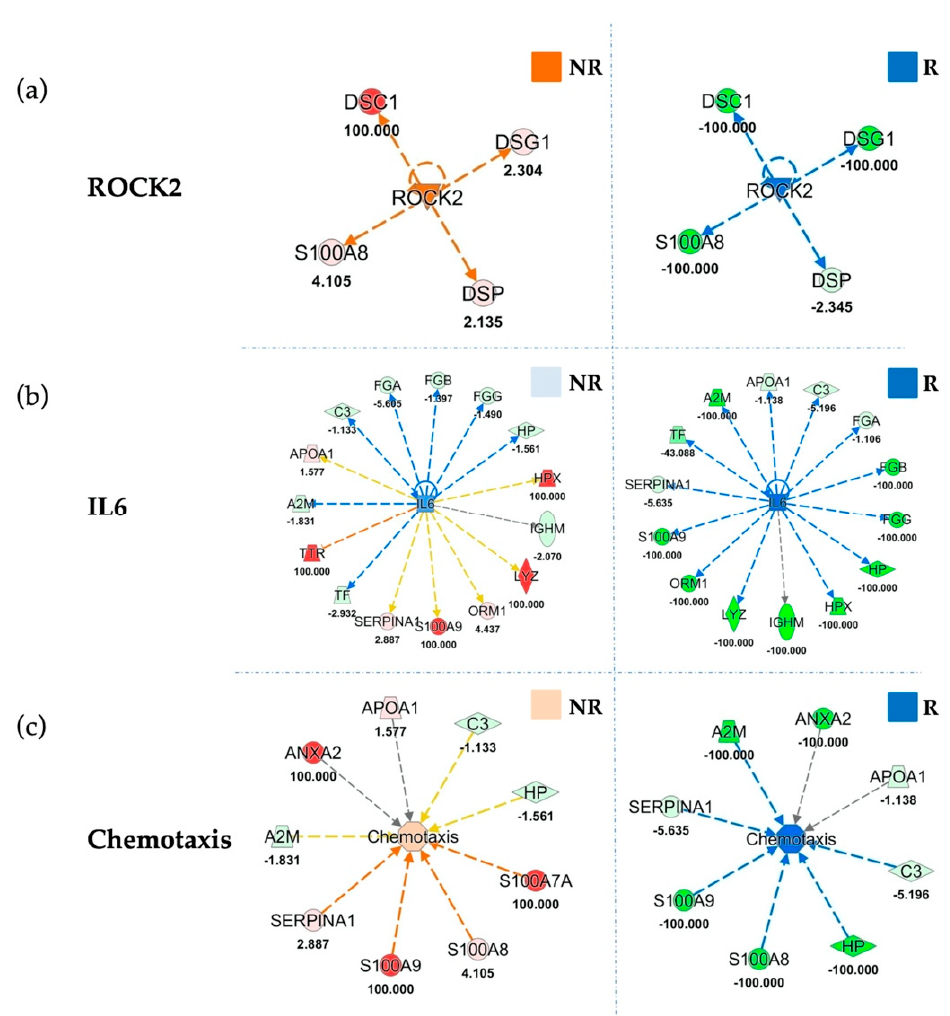
Figure 5. Functional Comparison Analysis between activated and inhibited pathways in sorted EVs from not responding (NR) and responding (R) patients, as compared to their respective baselines. Panel ( a ) highlights ROCK2 in NR and R sorted EVs compared to their baselines. Panel ( b ) shows IL6 modulation in NR and R EVs. Panel ( c ) reports the same comparison for “Chemotaxis” function. Overall ROCK2, IL6 and Chemotaxis are inhibited (blue) in responders, as compared to baseline, whereas in non-responders they result activated (orange) or unchanged (light blue). Red and green shapes represent increased or decreased measurements of identified proteins, respectively, whose fold change value is reported in the figure. Color key and symbols are reported in Supplementary Figure